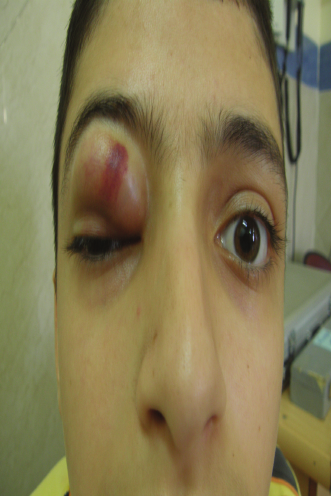
Figure 1: Right upper lid mass with ecchymosis led to mechanical ptosis.